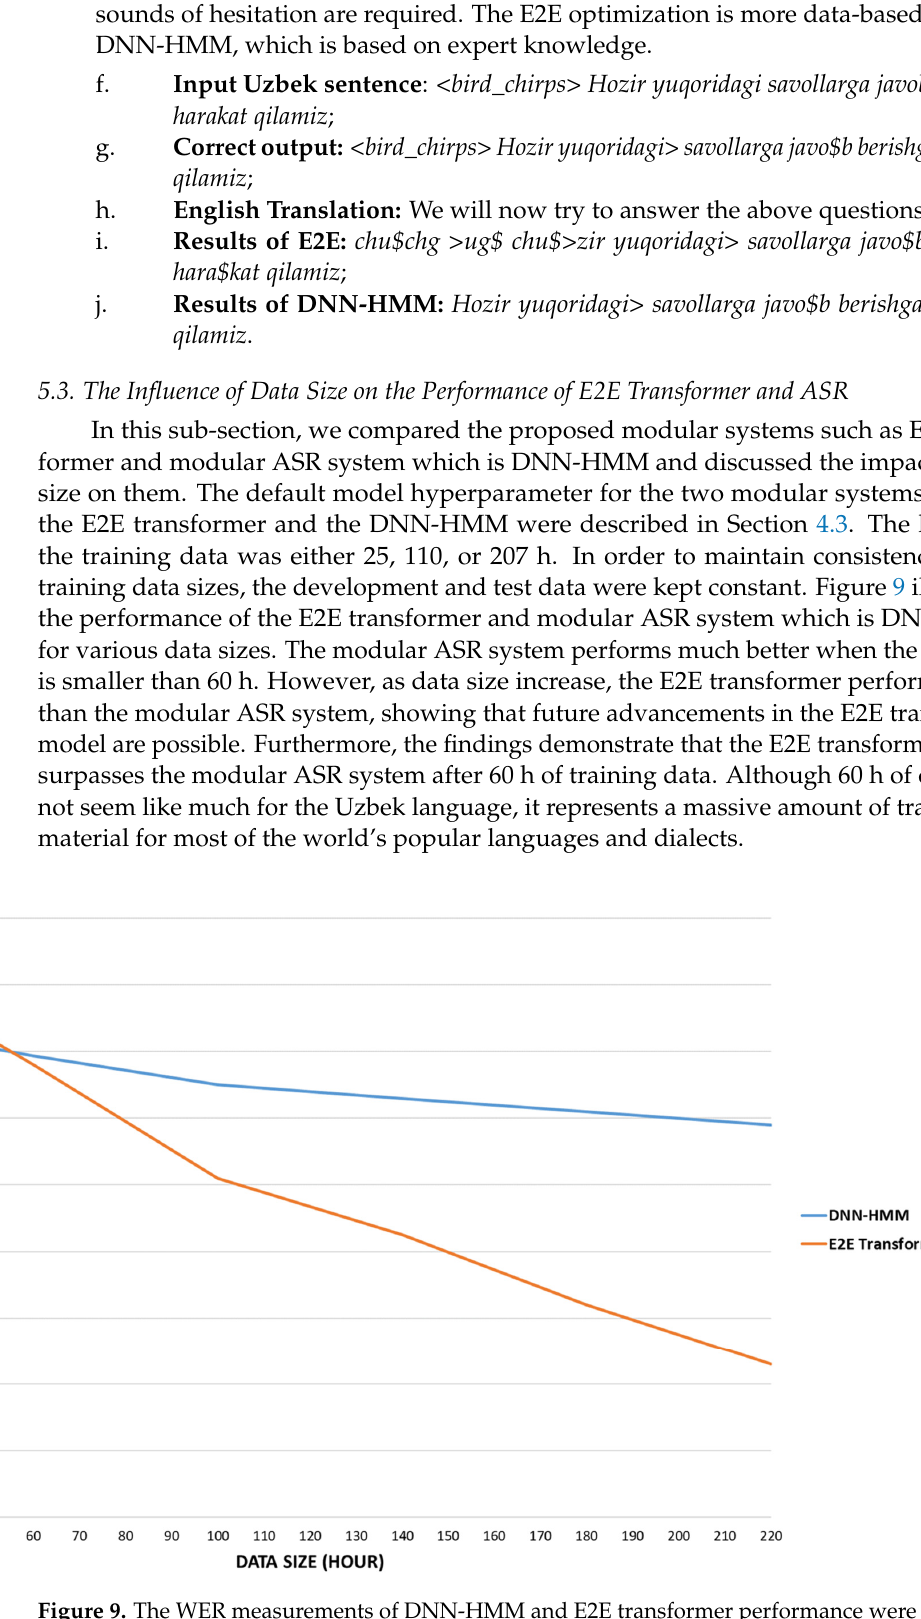
Figure 9. The WER measurements of DNN-HMM and E2E transformer performance were com- pared in various training data sizes.